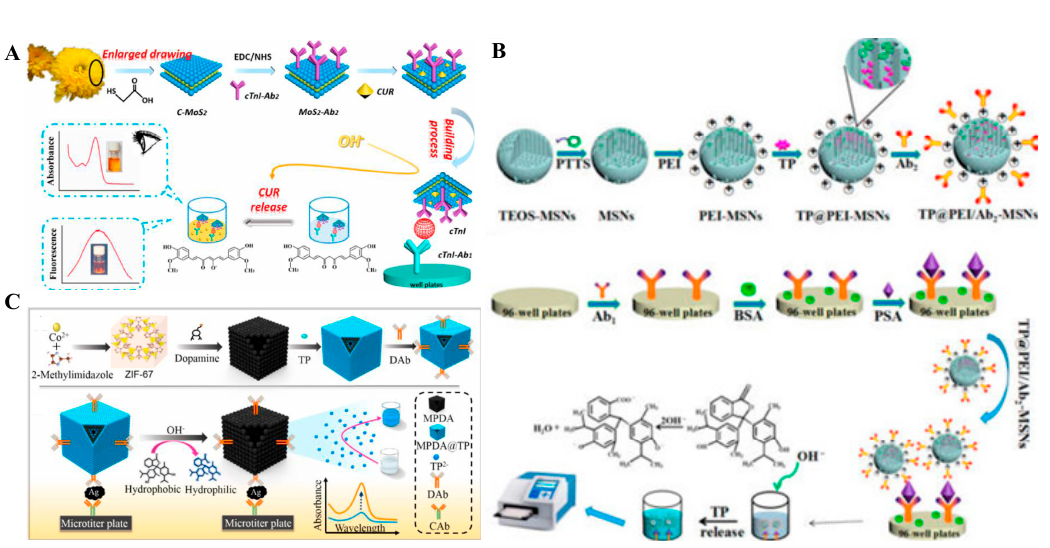
Reproduced with permission from [177]. Copyright American Chemical Society,